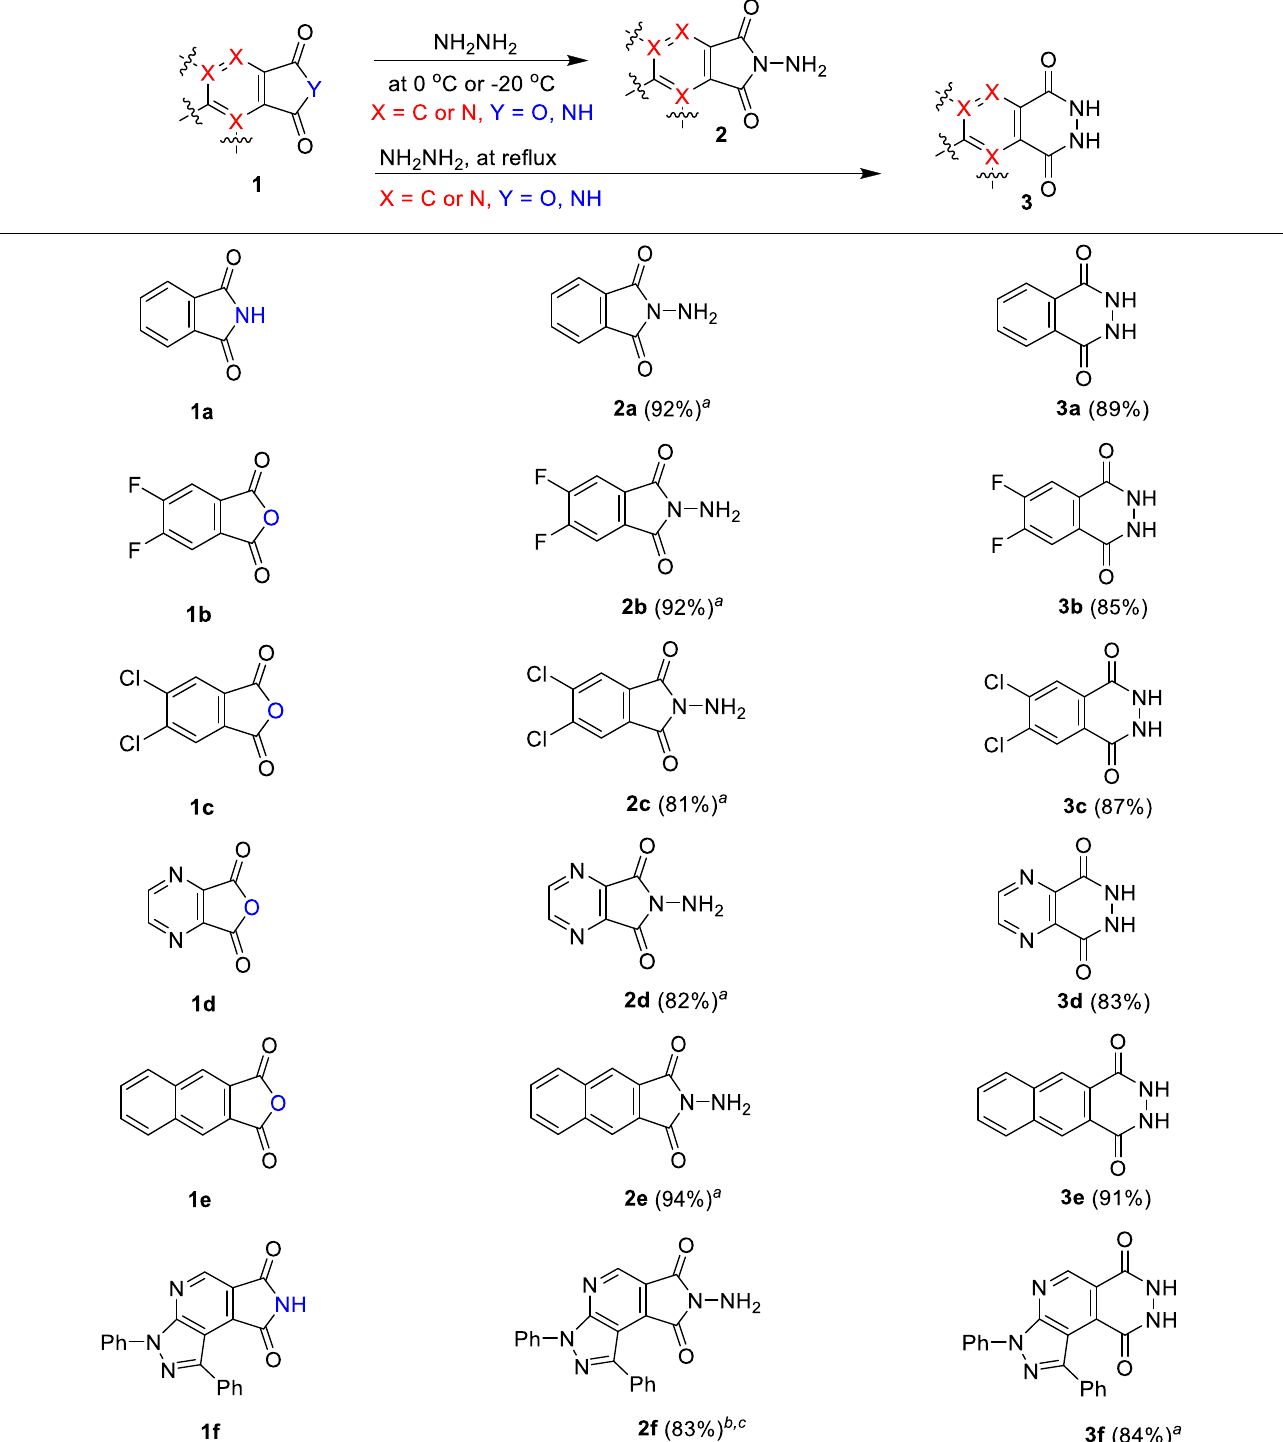
Molecules 2021 , 26 , x FOR PEER REVIEW